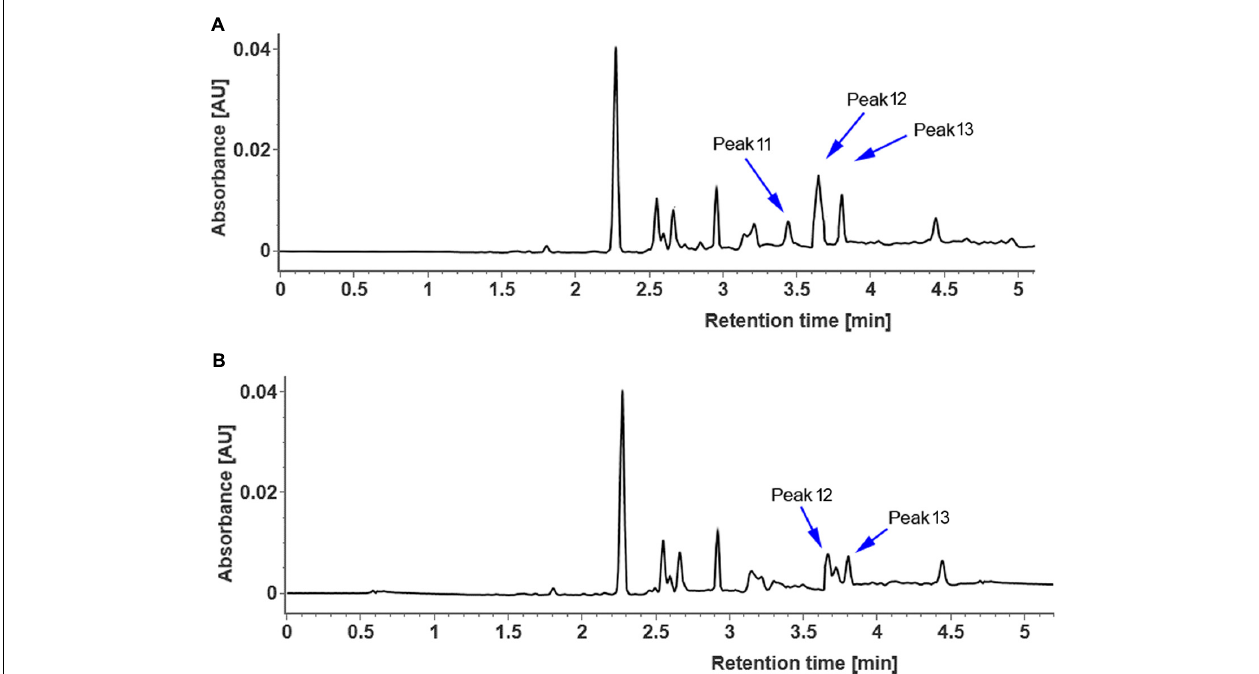
FIGURE 7 | UPLC chromatogram of flavonoid glycosides extracted from transgenic (A) and control (B) tobacco. Peaks 11–13 indicate enzymatic products listed in Supplementary Table S3 .